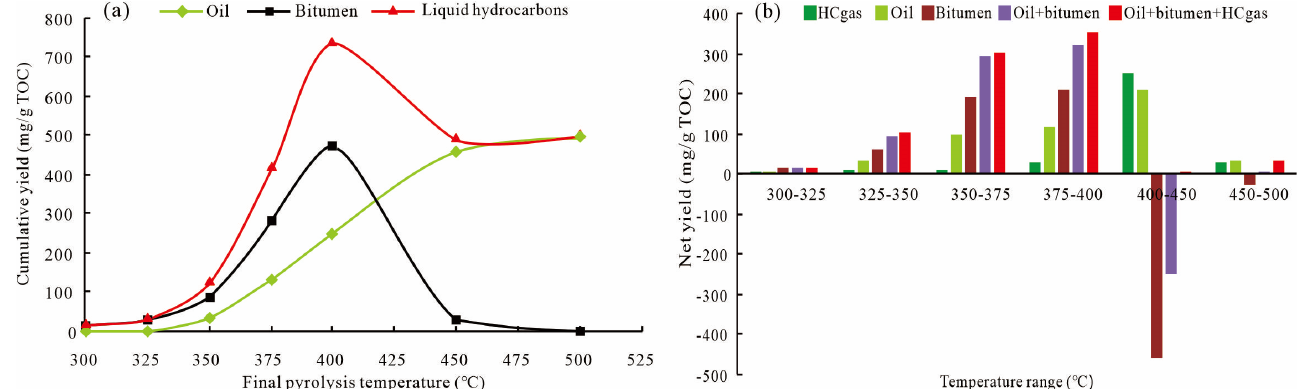
Figure 5. Compositional characteristics of the cumulative yields of oil, bitumen, and liquid hydrocarbons (oil+ bitumen) ( a ); net yields of hydrocarbon gases (HC gases), oil, bitumen, oil + bitumen, and oil + bitumen + HC gas ( b ) with the increase in the temperature.